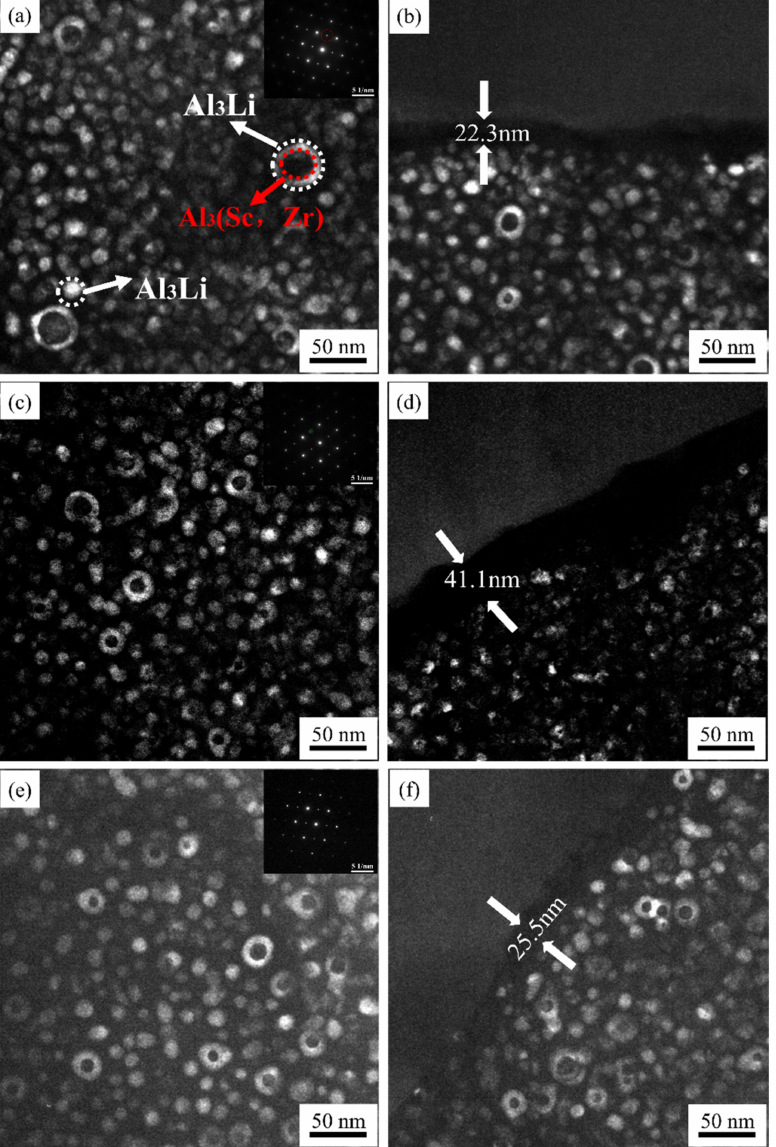
Figure 11. TEM dark-field images and electron diffraction spot maps of samples at different rolling temperatures after aging treatment: S420 ( a , b ), S450 ( c , d ), S480 ( e , f